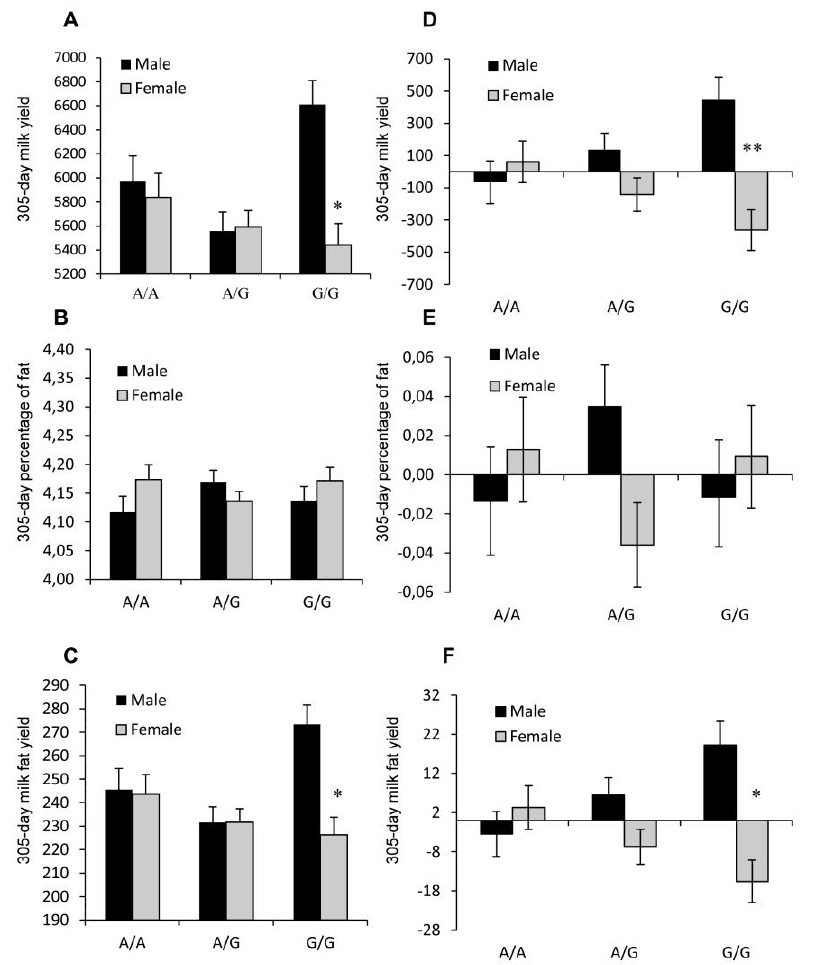
Figure 4. Influence of sex of the calf on the milk performance traits of cows with different TNF  -824A/G genotypes. Average data from first to fourth lactation are shown. Data are reported as mean  SEM. A, B, C: ANCOVA results for the 305-d milk yield, 305-d percentage of fat, and 305-d milk fat yield, respectively. Number of lactations is used as a covariate. D, E, F: ANCOVA analysis of residual variances of the same traits. * p<0.00004, ** p<0.02 relative to the bull calves corrected for multiple comparisons using Fisher's post-hoc LSD